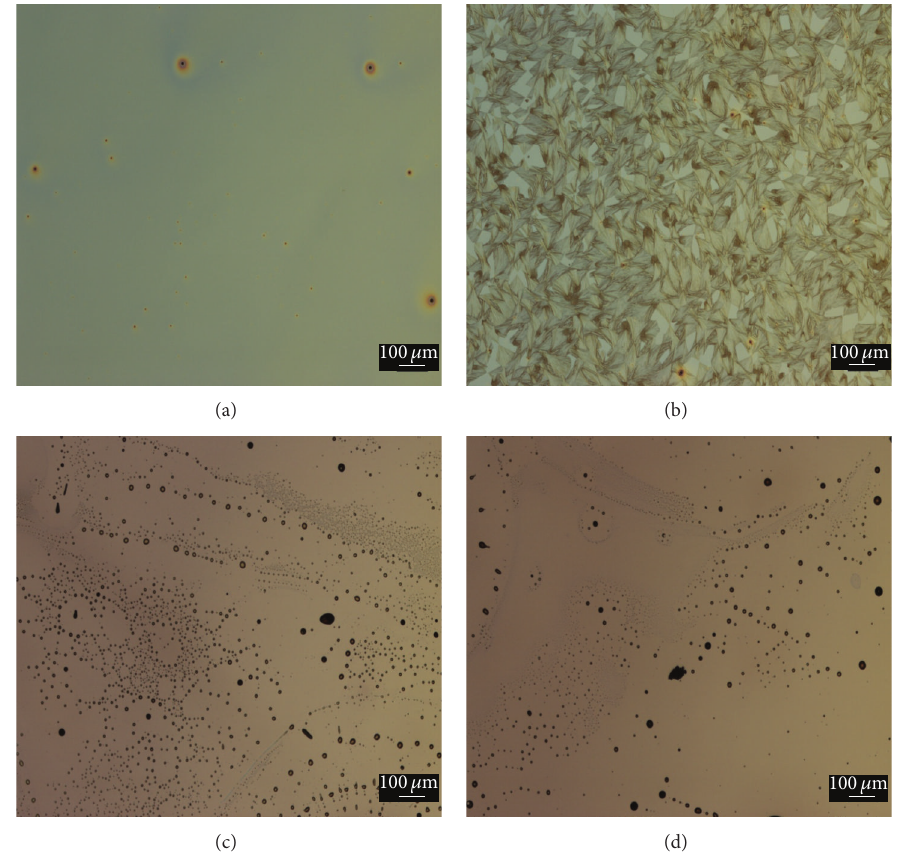
Figure 3: Optical microscope images, scale 100 𝜇 m: (a) pristine PC 60 BM layer unannealed, (b) pristine PC 60 BM layer annealed, (c) P3HT:PC 60 BM layer with 30 vol% glycerol additive unannealed, and (d) P3HT:PC 60 BM layer with 30 vol% glycerol additive annealed.